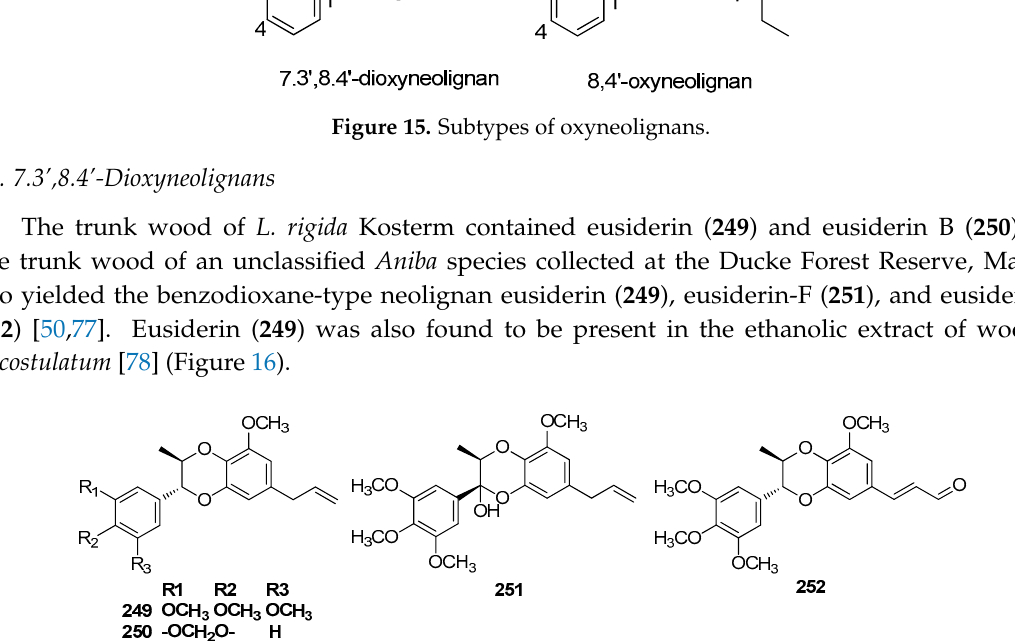
Figure 16. Chemical structures of 7.3’,8.4’-dioxyneolignans.